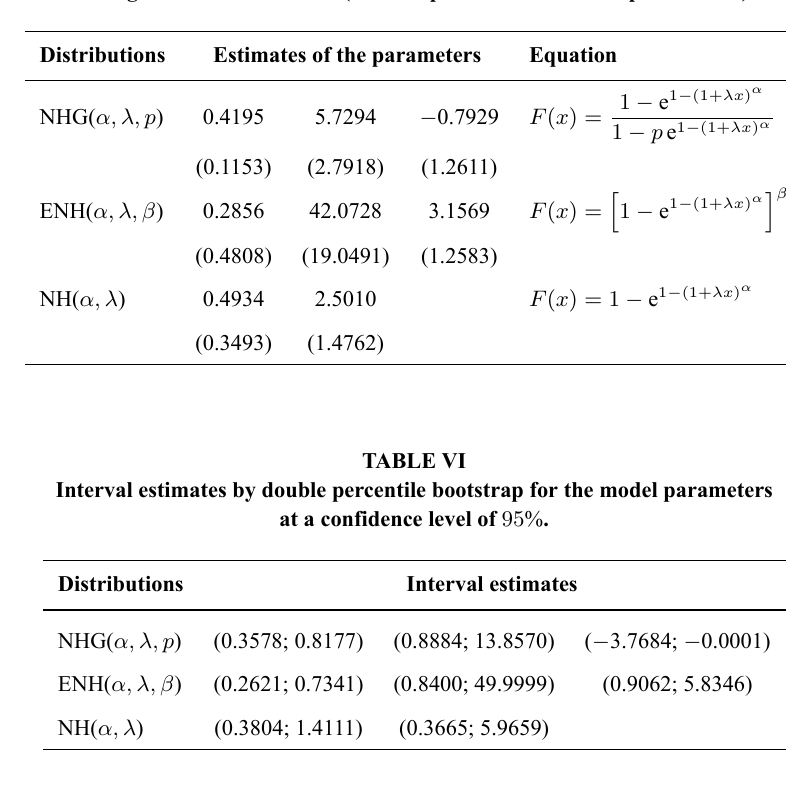
The MLEs of the parameters for the fitted NHG, ENH, NH and EXP models through of the PSO method (bootstrap standard errors in parentheses).